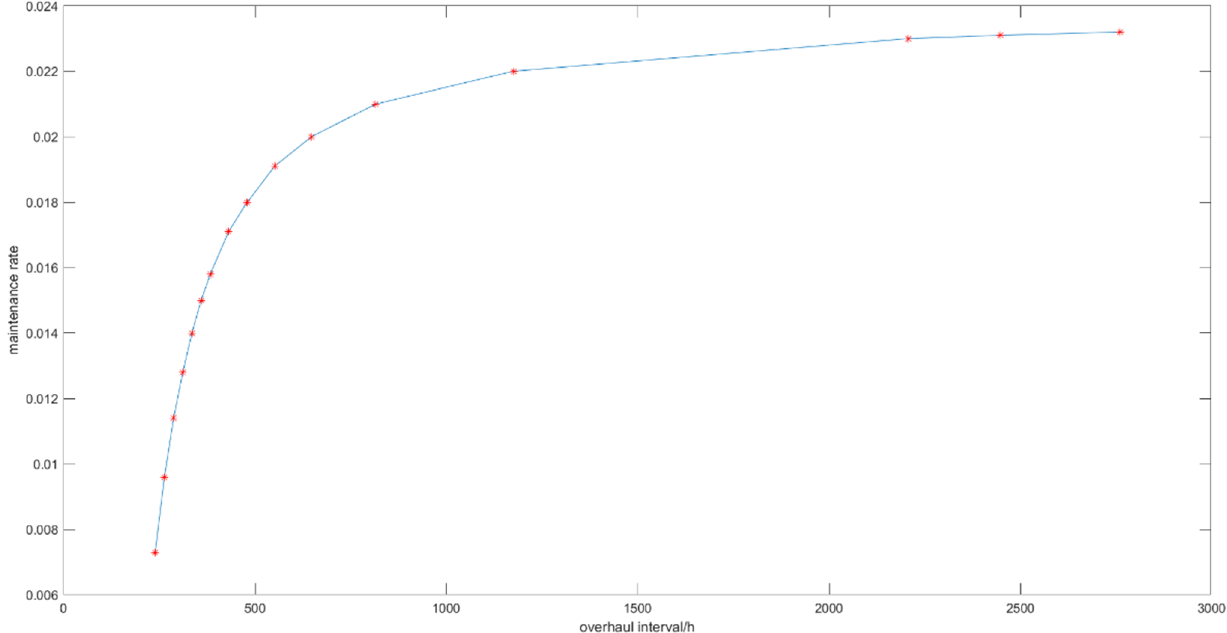
Figure 4. Variation of daily maintenance rate and overhaul interval with the same average safety index.